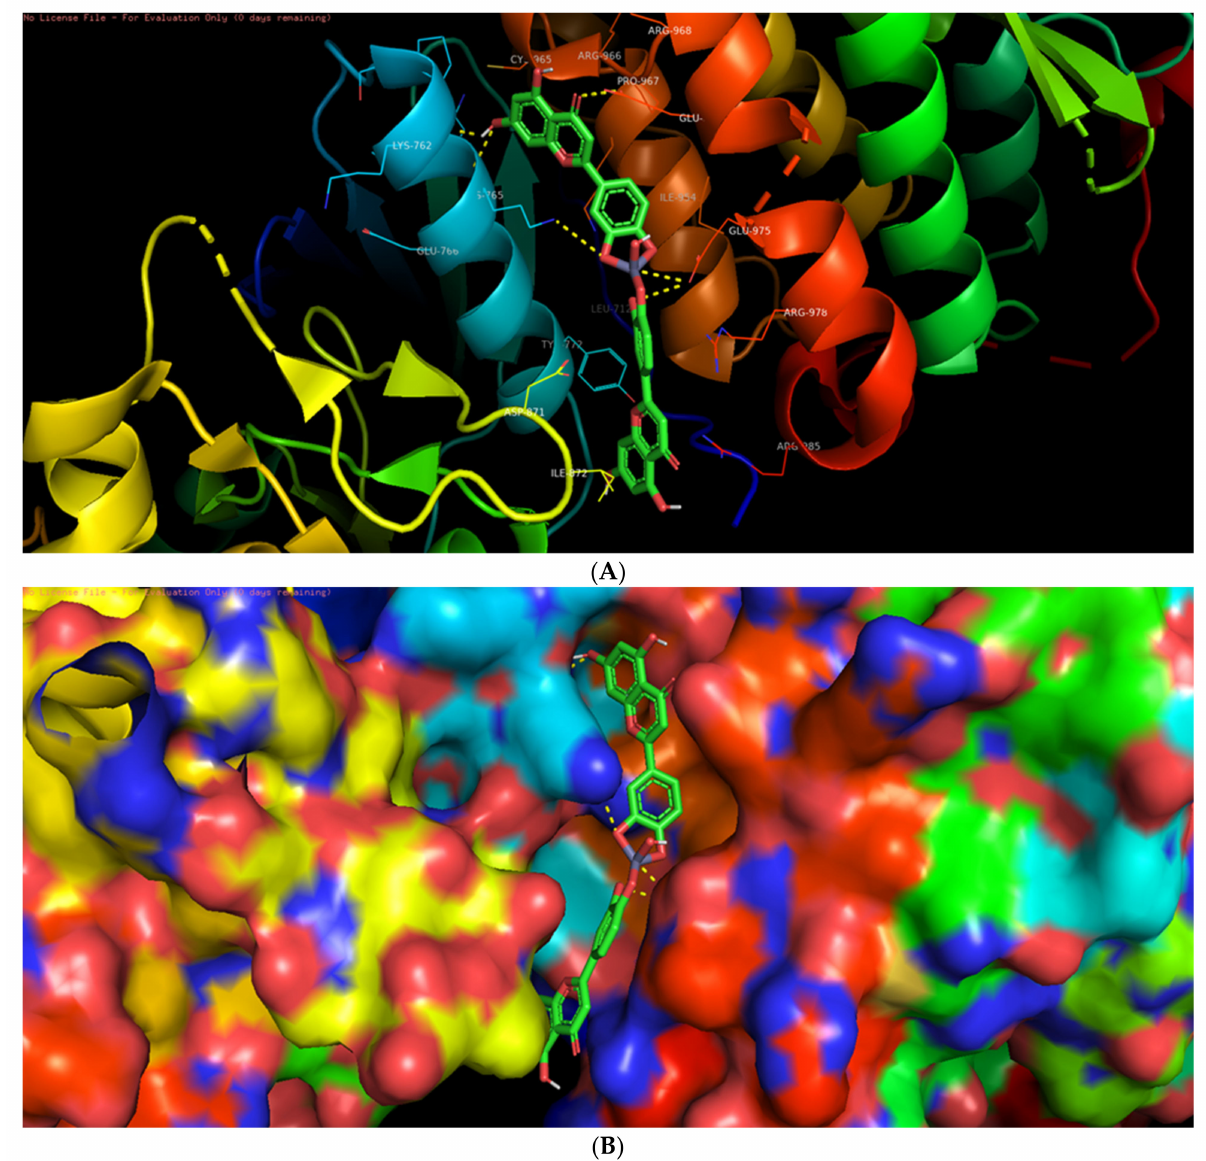
Figure 10. ( A ) The bonded and non-bonded interactions of L-ZnONPs with the cancer protein 3PP0. ( B ) The best-docked pose of L-ZnONPs bound to the hydrophobic preset of the 3PP0